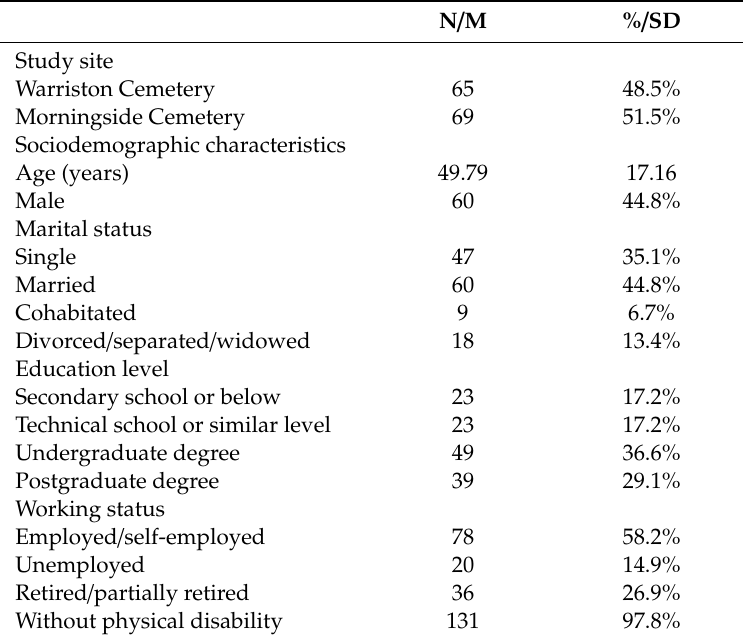
Table 1. Descriptive analysis for the sample ( N = 134).